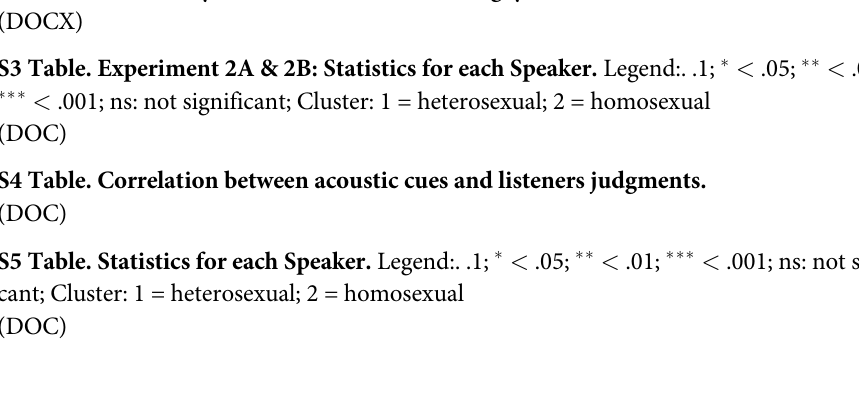
S3 Table. Experiment 2A & 2B: Statistics for each Speaker. Legend:. .1; (cid:1) < .05; (cid:1)(cid:1) < .01; (cid:1)(cid:1)(cid:1)